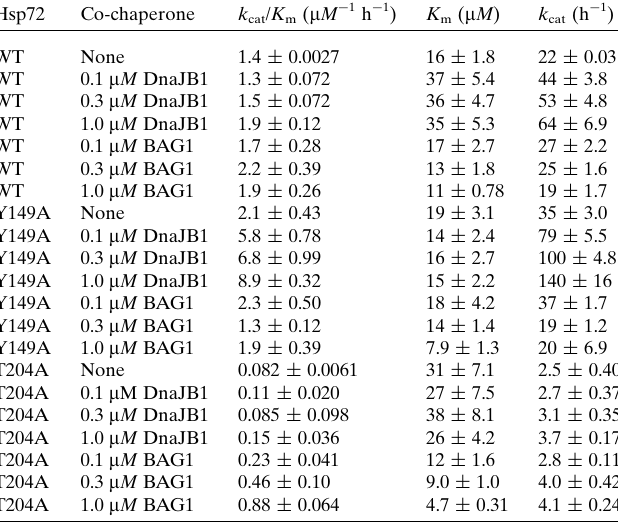
Table 4 Kinetic parameters for the ATPase activity of WT-Hsp72, Y149A-Hsp72 and T204A-Hsp72 in the presence and absence of co-chaperones. Hsp72 Co-chaperone